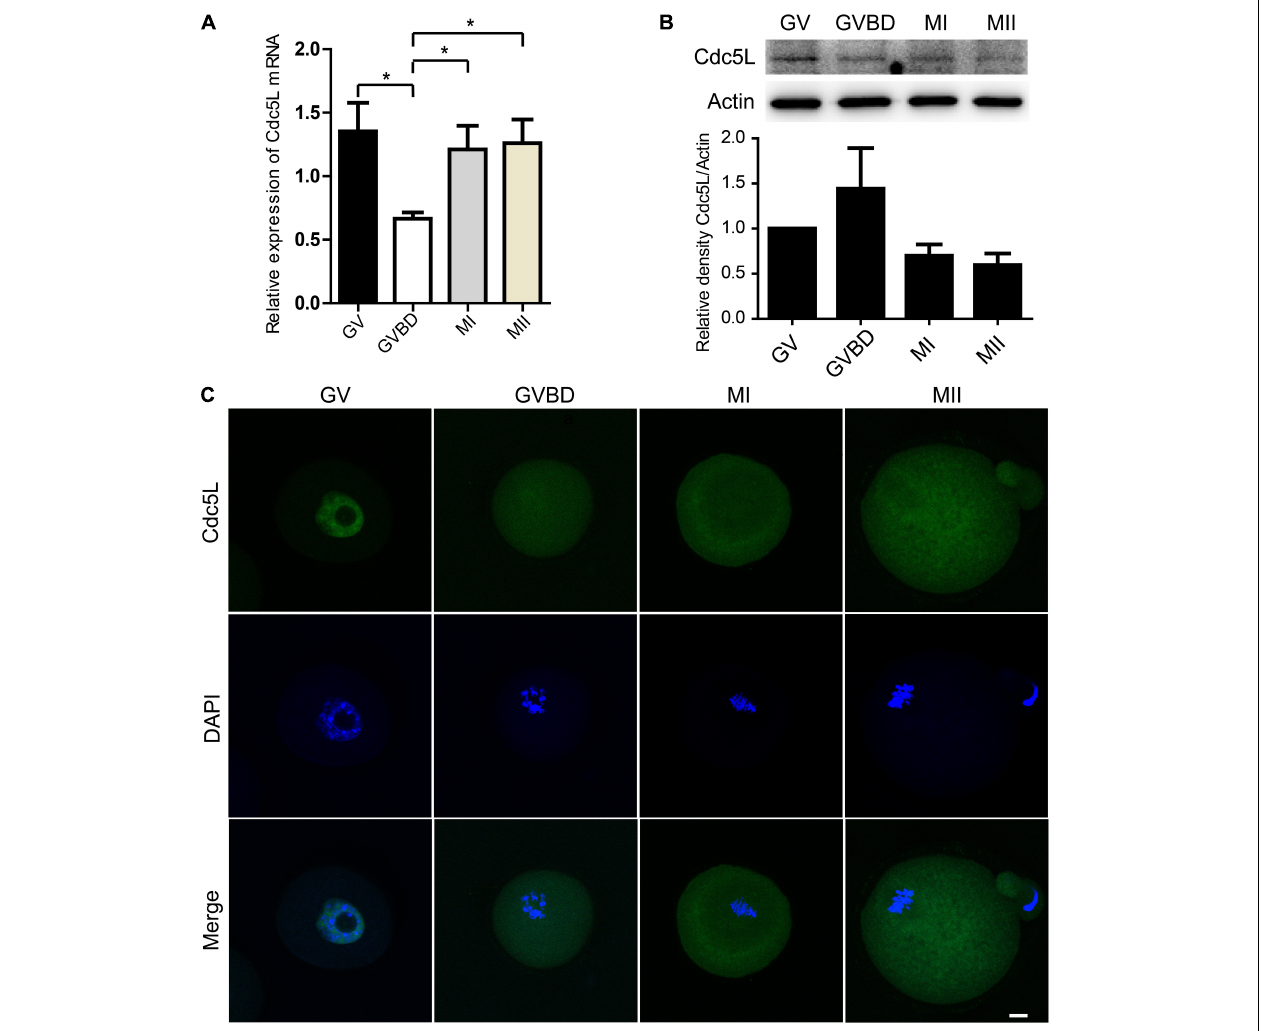
FIGURE 1 | Expression and subcellular localization of Cdc5L during mouse oocyte meiotic maturation. (A) Relative level of Cdc5L mRNA identified by RT–PCR. A total of 50 oocytes were collected for each sample. At least three replications were conducted, and 150 oocytes were used for each group. Data are shown as means ± SEM. “*” represents P < 0.05; “**” represents P < 0.01. (B) Expression of Cdc5L protein revealed by Western blotting analysis. A total of 150 oocytes were collected after culture for 0, 4, 8, and 12 h; time points when most oocytes had reached GV, GVBD, MI, and MII stages, respectively. At least three replications were conducted, and 450 oocytes were used for each group. β -actin is shown as an internal control. (C) Subcellular localization of Cdc5L as revealed by immunofluorescence staining. Confocal microscopy images that showed subcellular localization of Cdc5L (green) and DNA (blue) was counterstained with DAPI. Scale bars: 10 µ